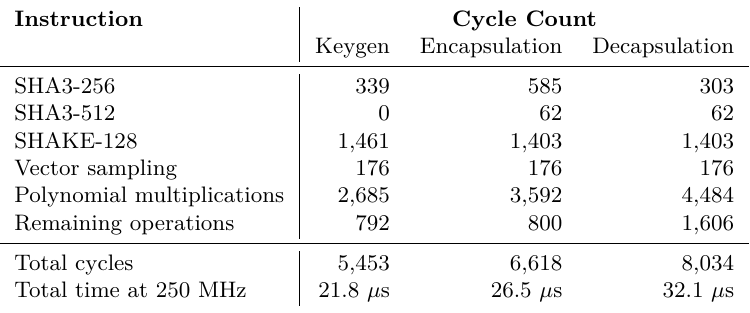
Table 1: Total cycles spent in low-level operations for Saber (module dimension 3). The polynomial multiplier uses 256 MAC units in parallel, with each MAC equipped with one